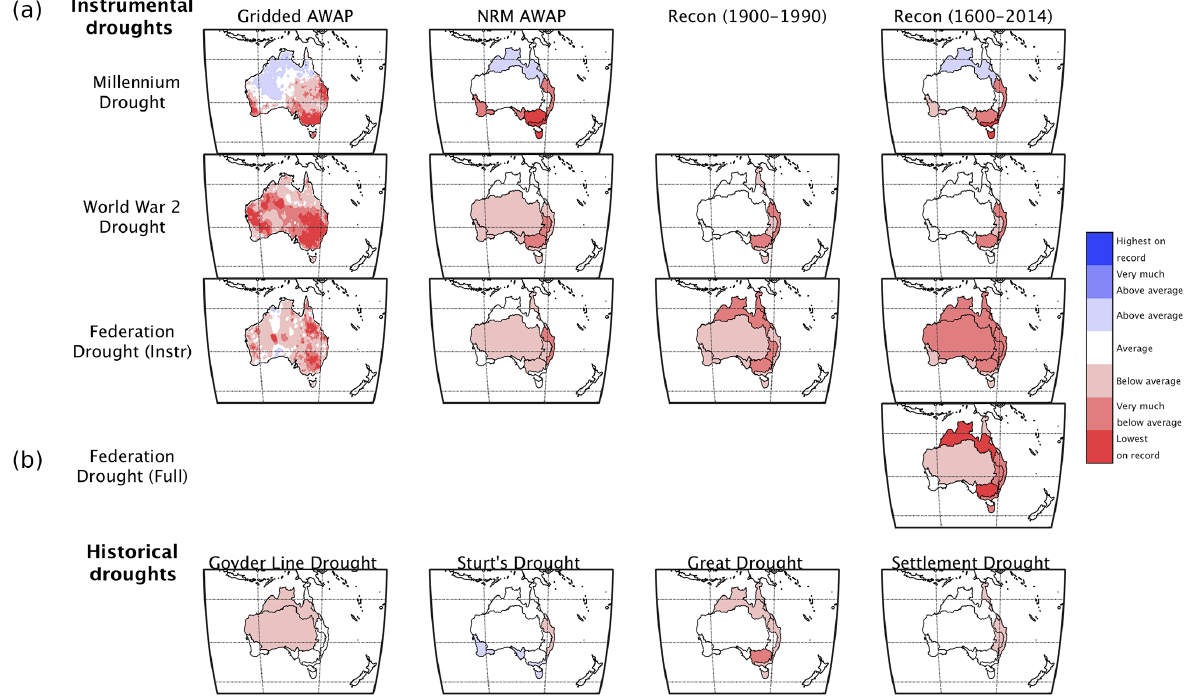
Figure 7. Annual deciles for major droughts. Plots for (a) Significant drought periods (according to Table 1c) during the instrumental period. Rankings of drought intensity are shown for three major instrumental period droughts. Column 1: AWAP gridded rainfall (1900–2014); column 2: NRM clusters (1900–2014); column 3: regional reconstructions during instrumental period (1900–1990); column 4: regional reconstructions during a four-century period (1600–2014). (b) Rankings of major drought periods during the reconstruction period (1600–